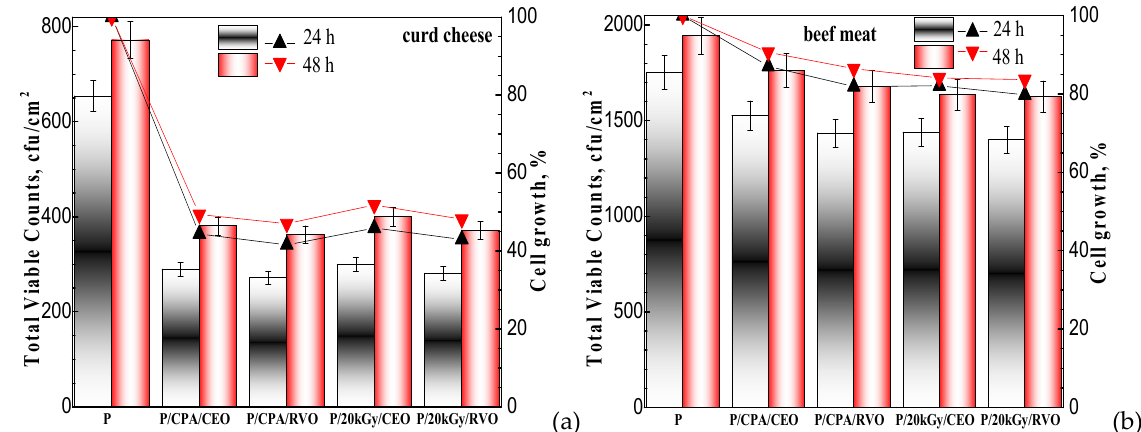
Figure 6. Total Viable Counts of untreated and of plasma activated or γ -irradiated followed by plant oils loading of kraft paper for fresh curd cheese ( a ) and fresh beef meat ( b ).